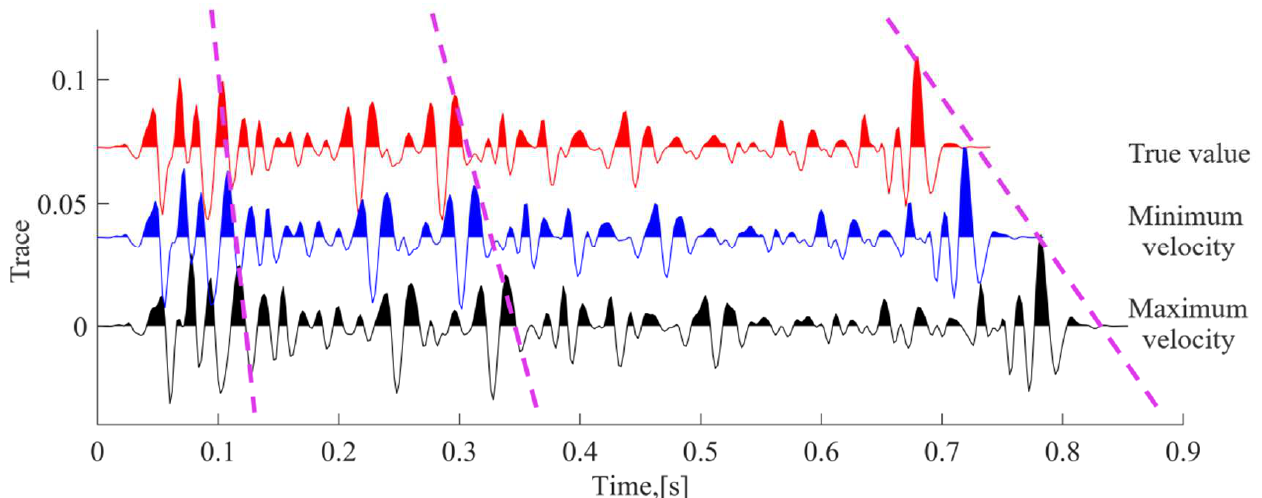
Figure 9. Comparison of synthetic seismic data by using upscaled velocity from the maximum and minimum velocity of the SLS model in Figure 6a.